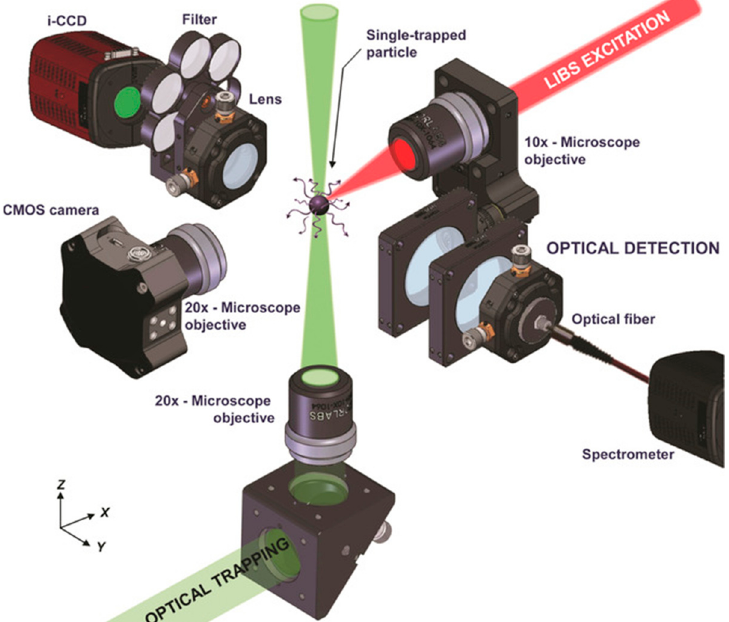
Figure 11. Experimental setup featuring the multiple lines of the instrument with main components labelled. Optical trapping was performed using a 532 nm Nd:YAG CW laser and a pulsed Nd:YAG at 1064 nm was used for LIBS analysis. (Reprinted with permission from [195], Copyright (2017) John Wiley and Sons).